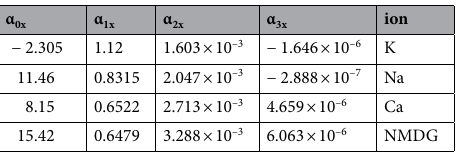
Table 1. Current coefficients listed in Eq. (1) for different